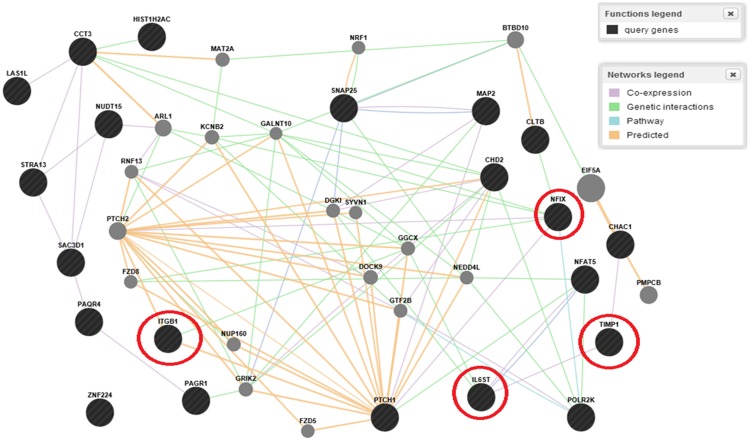
Circled are the known regulated genes and predicted master regulator NFIX as a final direct network that underwent the validation based on in-silico prediction results.